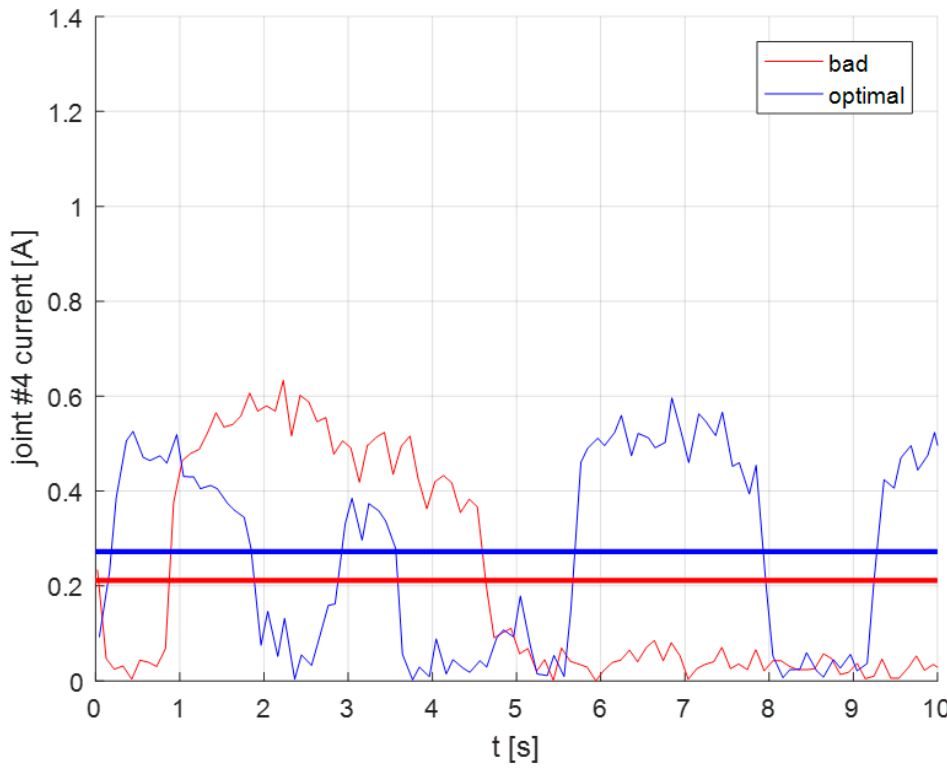
11 Figure 11. Current utilization and mean current during task execution in both locations for joint 4.